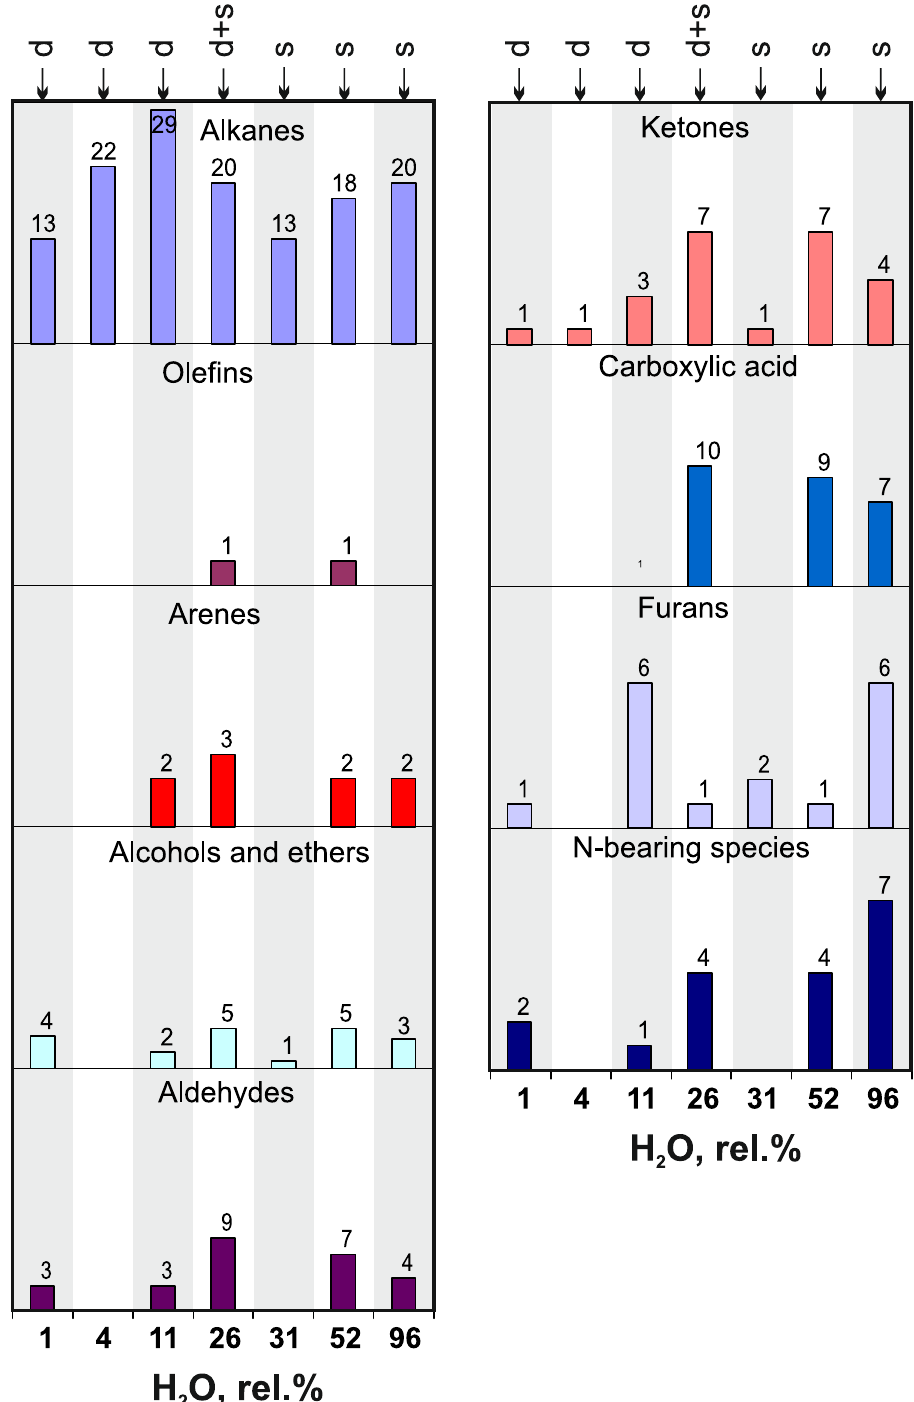
Figure 5. Diversity of alkanes, alkenes, and oxygenated hydrocarbons revealed by GC-MS analysis in quenched C-O-H-N fluids as a function of normalised areas of H 2 O at 6.3 GPa, 1400 °C, run duration ≥ 2 hours in MMO- buffered f H 2 and in unbuffered experiments. Letter symbols are same as in Fig.